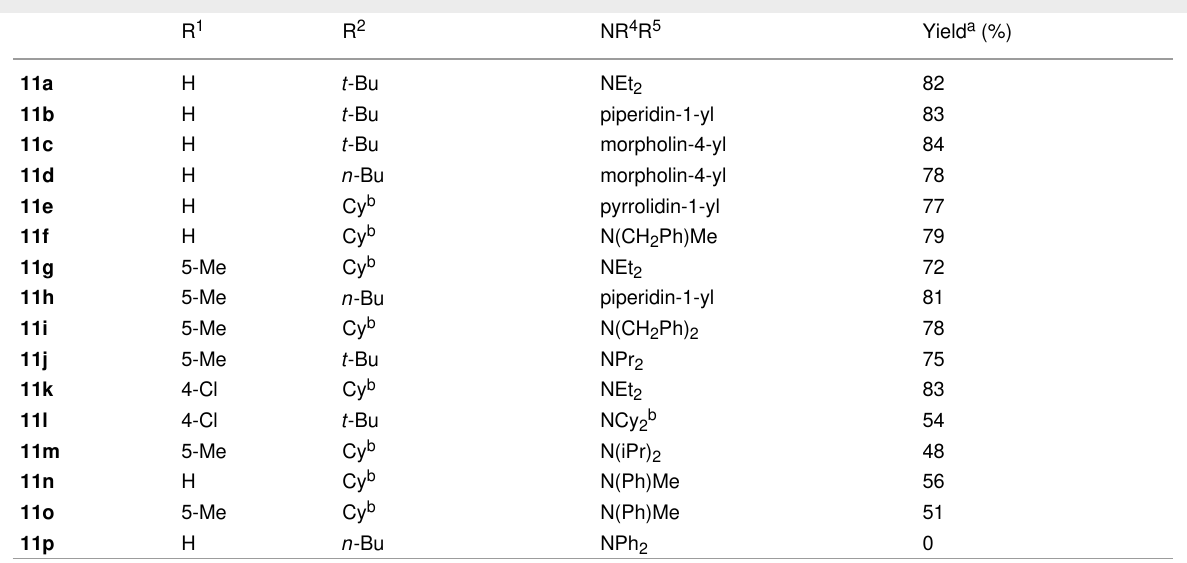
Table 3: Yields of 4 H -3,1-benzothiazines 11